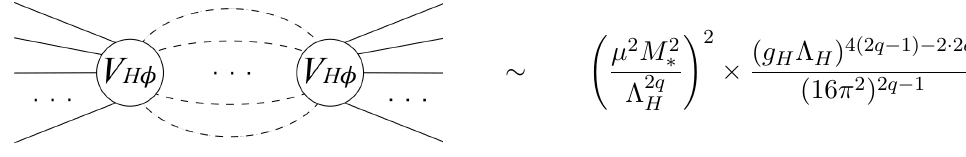
Figure 4 . Schematic diagram giving loop corrections to the potential V φ from two insertions of V Hφ . The scalar φ is denoted by a continuous line, the 2 q Higgs propagators by dashed